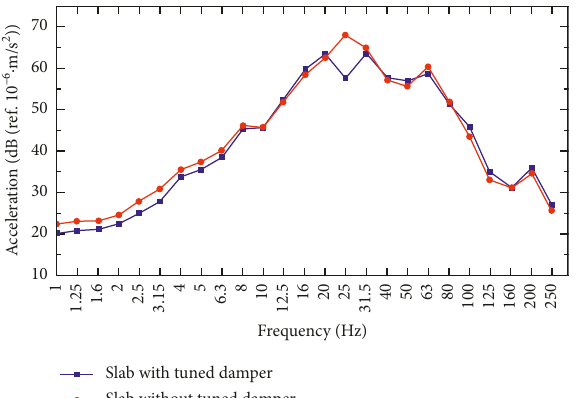
Figure 14: 1/3 frequency path spectrum of track foundation (hammered at the middle point between adjacent fasteners).